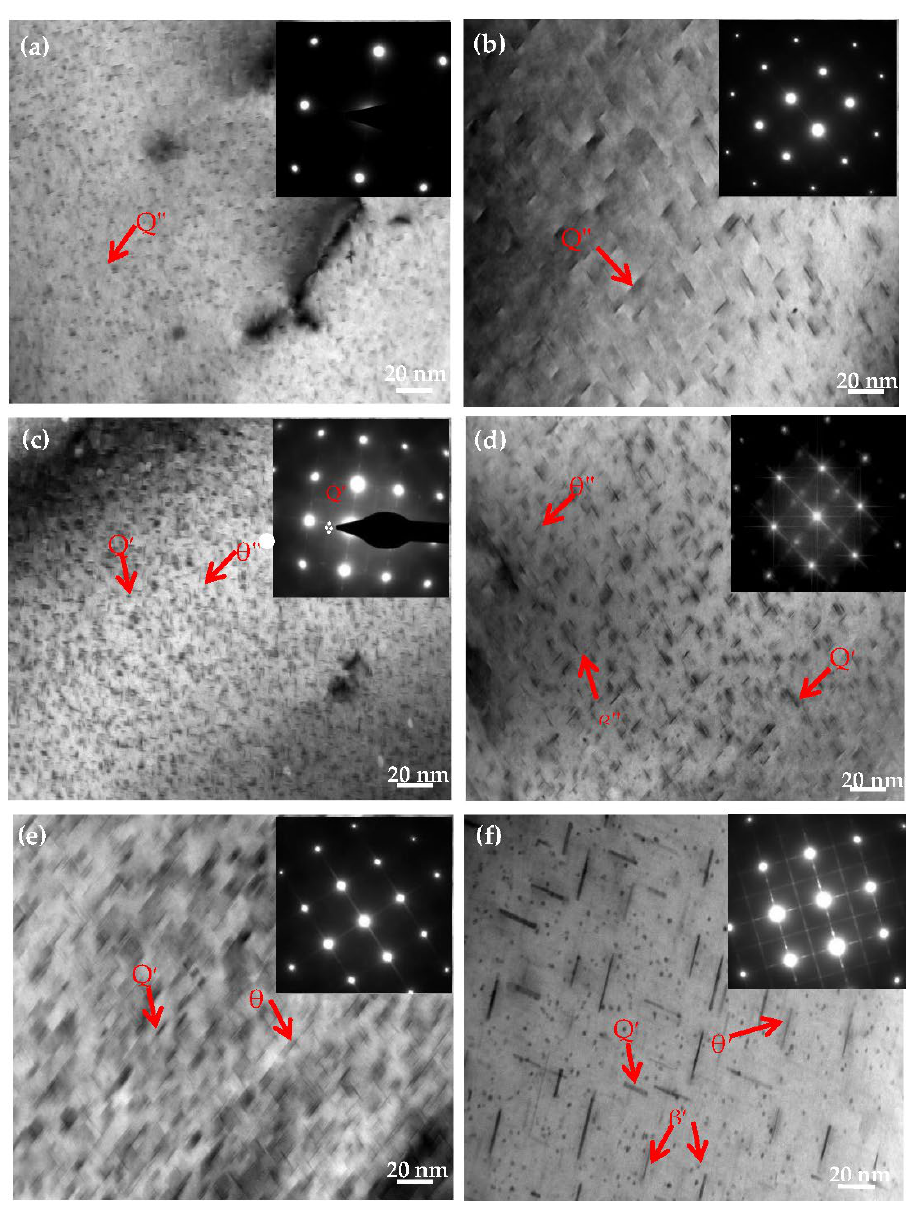
Figure 9. TEM images of the formed semisolid hypereutectic Al − 17Si − 4Cu − xMg alloys at different ageing times, and associated SADP of [001]Al: ( a , b ) under aged, ( c , d ) peak aged, ( e , f ) over aged.